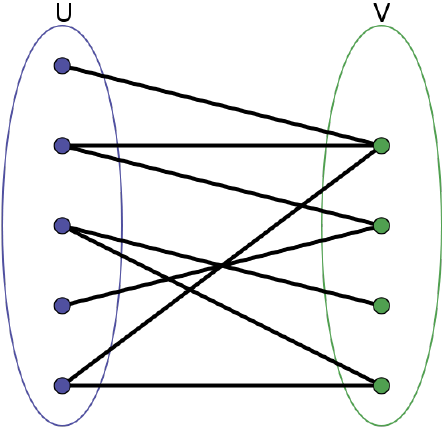
Figure 2. An example of bipartite graph.